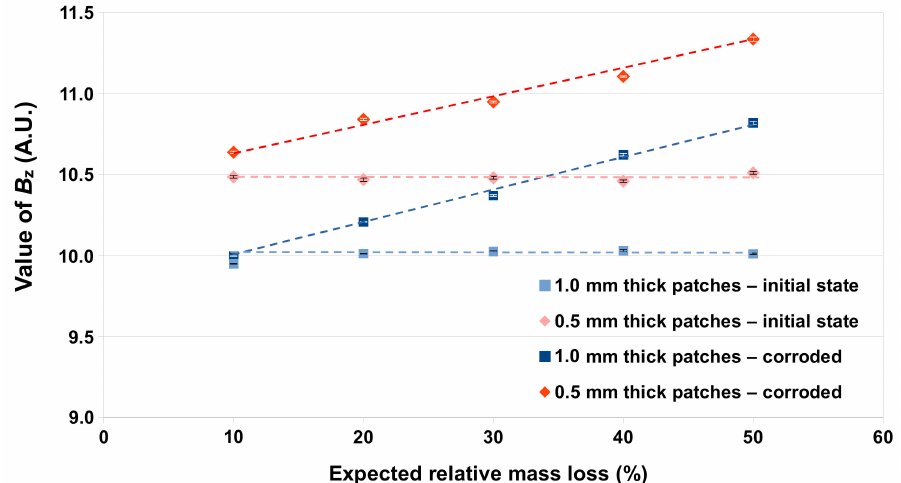
Figure 13. Mean value of B z measured with the 3D-magnetometer of each sample before and after corrosion and at a distance of 30 mm; clear marks that correspond to measurements of non-corroded samples are placed on the expected relative mass loss axis so that their value of B z before and after corrosion could be